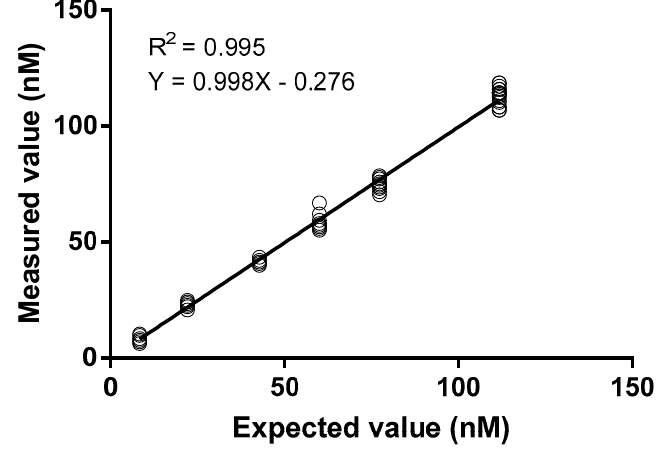
Figure 1. Linearity of folate measurements in spiking experiments show lower and upper levels of quantification of 8.4 and 111.7 nM, respectively. A pool of skimmed breast milk with folate levels at the lower limit of quantification (LLOQ) was thereto spiked at 5 different levels with the folate stock solution, diluted 7-times and then heated for 5 min at 90 °C (see Methods section for details). At each of these 6 levels, 6 measures were performed on 3 different days.